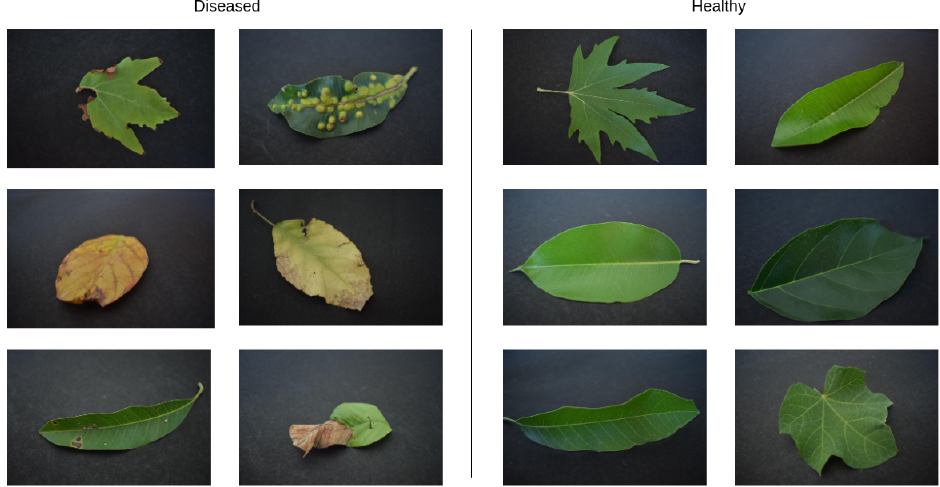
Figure 7. Sample of healthy and diseased leaf images obtained from the